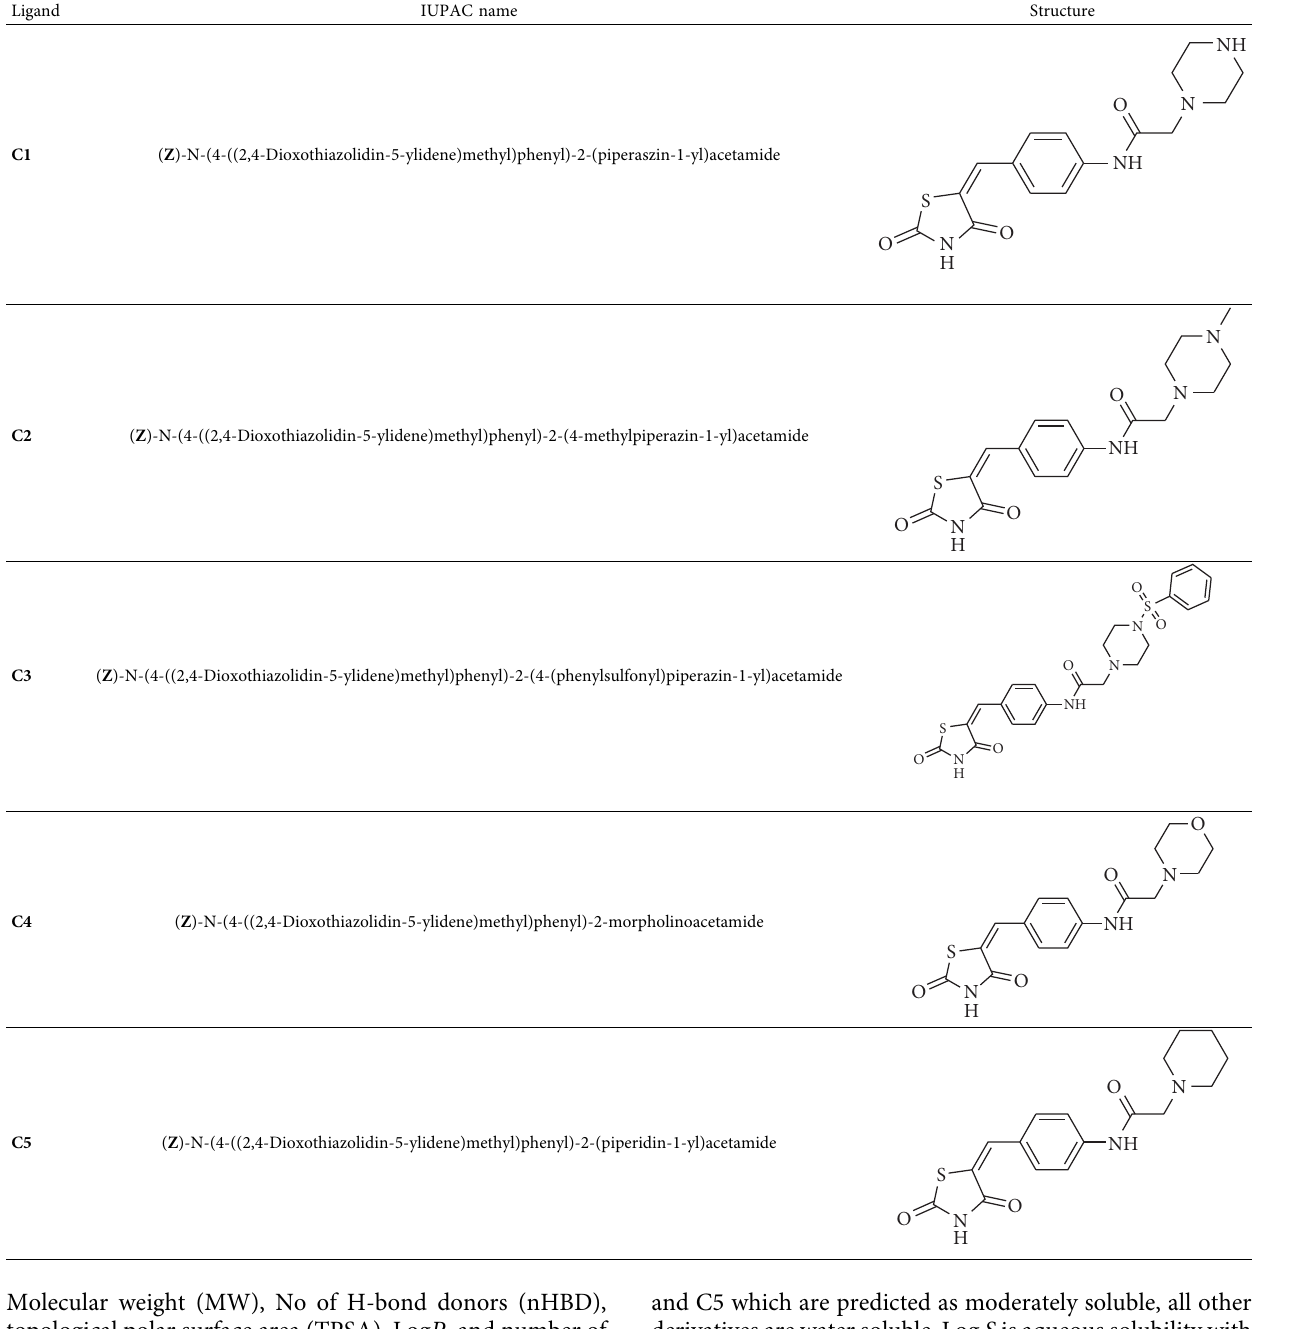
Table 1: IUPAC name and structure of TZDs (C1–C5)